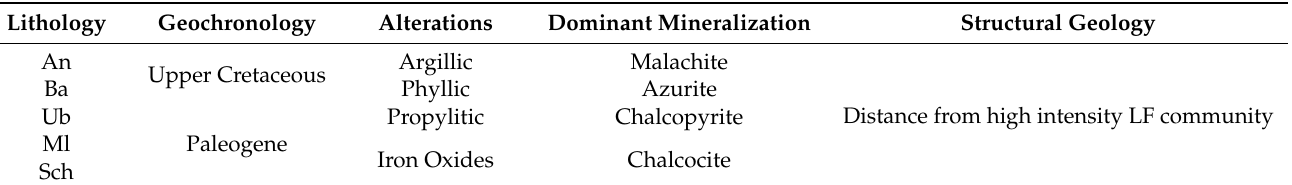
Table 3. Factors of the copper occurrences in the Sahlabad mining area used as the input for the BPNN algorithm.